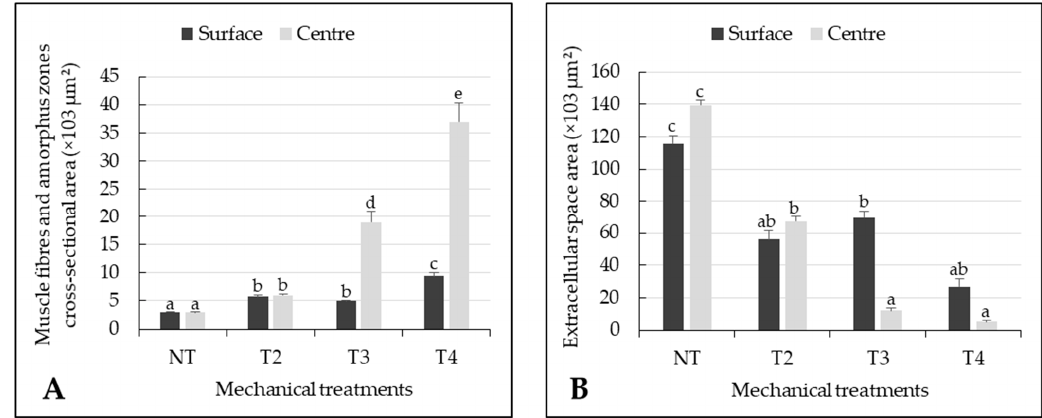
Figure 5. ( A ) Muscle fibre and amorphous ‐ zone cross ‐ sectional area and ( B ) Extracellular space area of raw meat pieces from beef Semitendinosus having undergone four different mechanical treatments: NT (control, no mechanical treatment applied), T2 (6000 compression cycles, about 7.5 h), T3 (9500 compression cycles, about 12 h) and T4 (13,000 compression cycles, about 16 h) at two different levels, i.e., surface and centre. Data are expressed as means +/ − standard error calculated from 8 images per level from three different meat pieces. Means with different letters (a–e) are significantly different ( p < 0.05) according to the Tukey test.